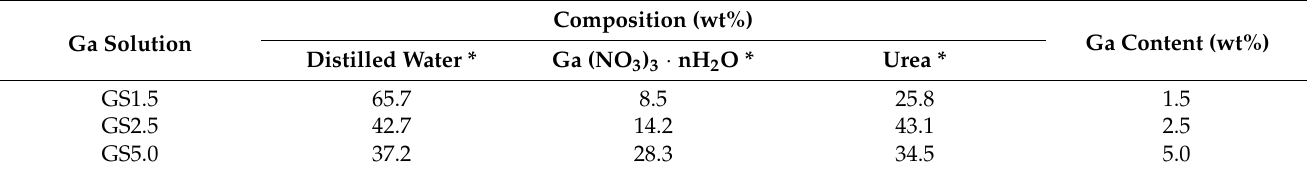
Table 3. Composition of Ga